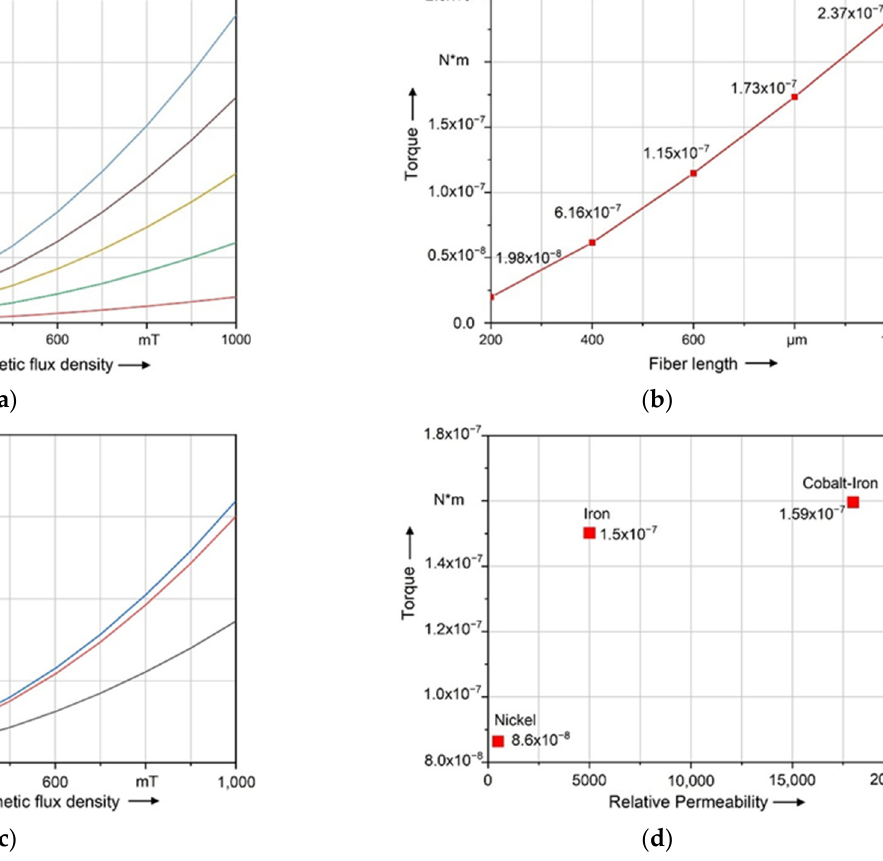
Figure 9. Magnetostatic simulation—resulting magnetic torque (M): ( a ) dependency of fiber lengths at different magnetic flux densities; ( b ) dependency of fiber lengths at a constant magnetic field of B 0 = 500 mT; ( c ) dependency of coating materials/different relative permeabilities ( µ r,c ) at different magnetic flux densities; ( d ) resulting magnetic torque depending on coating materials at a constant magnetic field of B 0 = 500 mT.